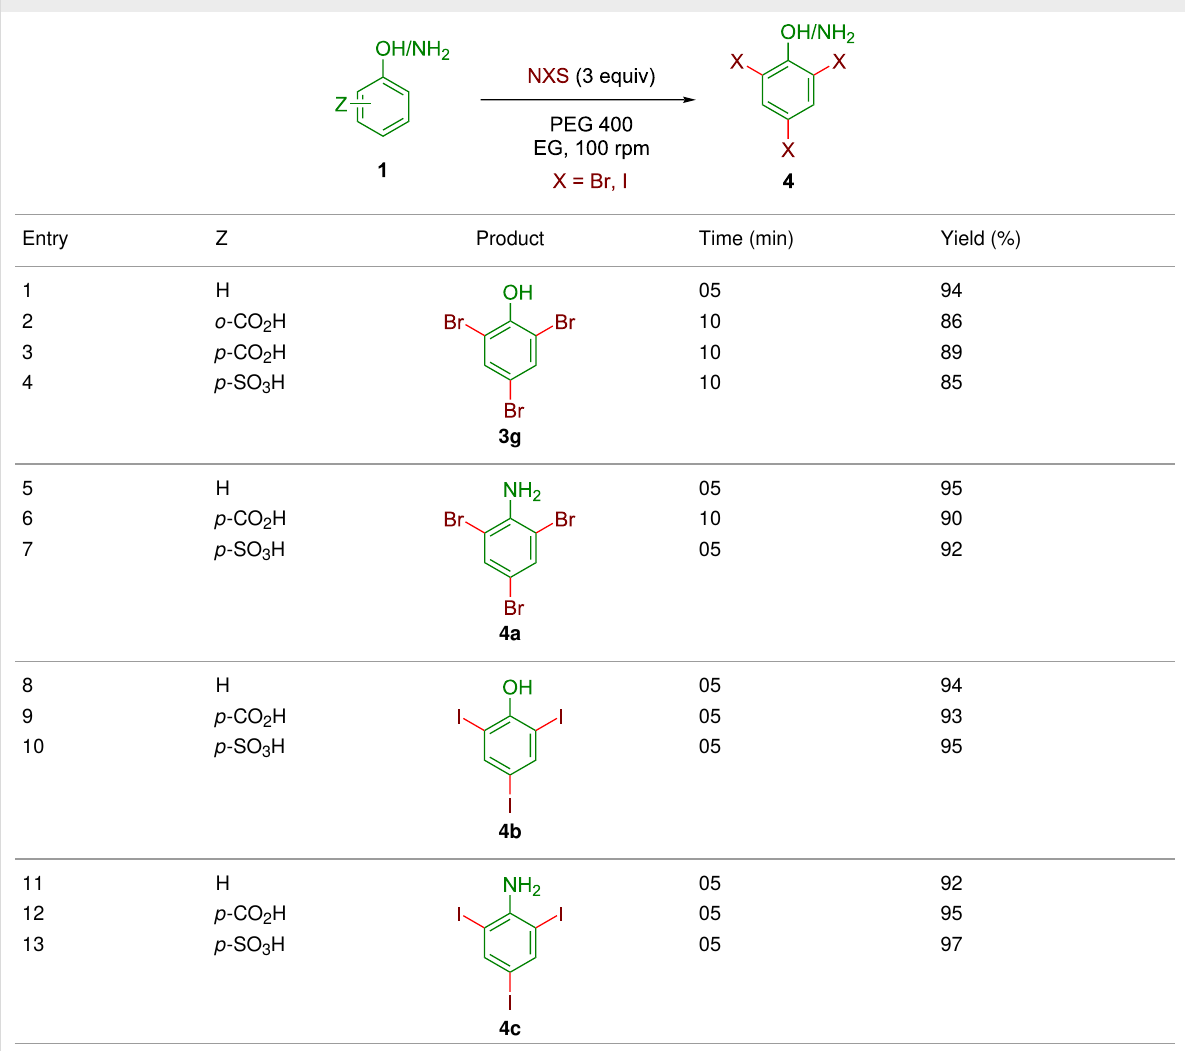
Table 2: Trihalogenation of phenols and anilines with NXS by automated grinding. a